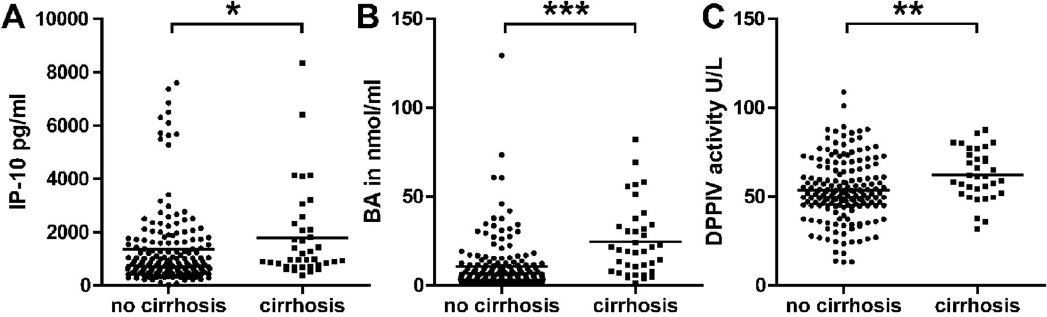
Fig 2. HCV patients with cirrhosis. HCV patients with cirrhosis (n = 38) had significantly higher IP-10 and BA serum levels as well as DPPIV serum activity compared to patients without cirrhosis. Total HCV cohort n = 229. Mean ± SD. � = p < 0.05; �� = p < 0.01; ��� = p < 0.001 (Wilcoxon Mann Whitney